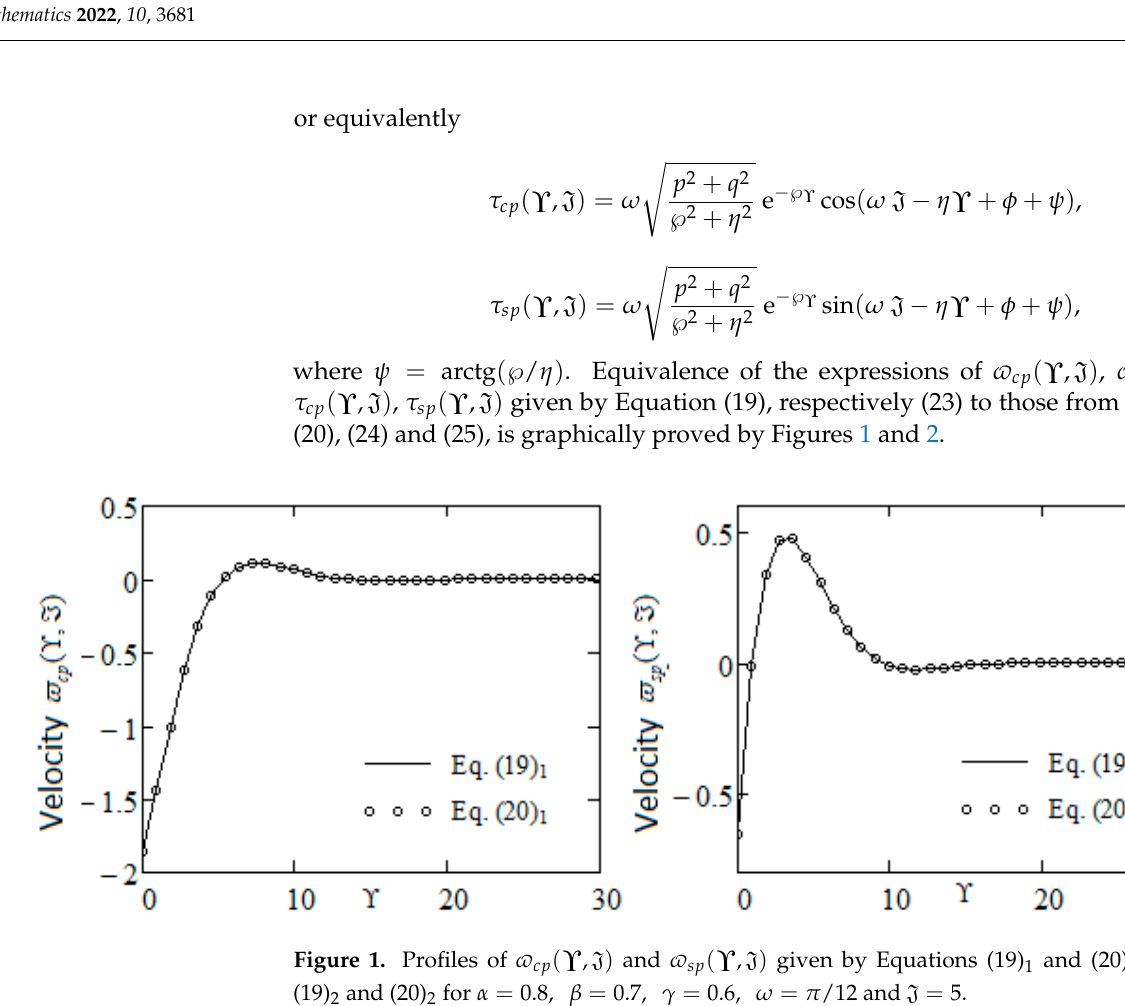
The dimensionless forms of the relations (4) and (5), namely ; ,